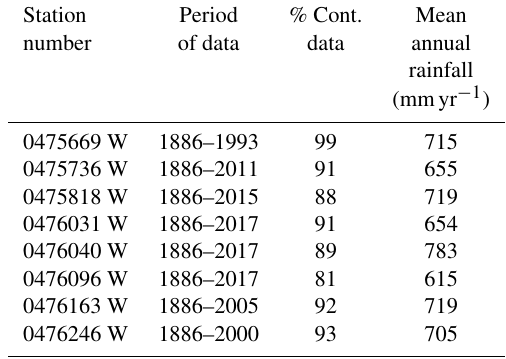
Table 1. Rainfall station